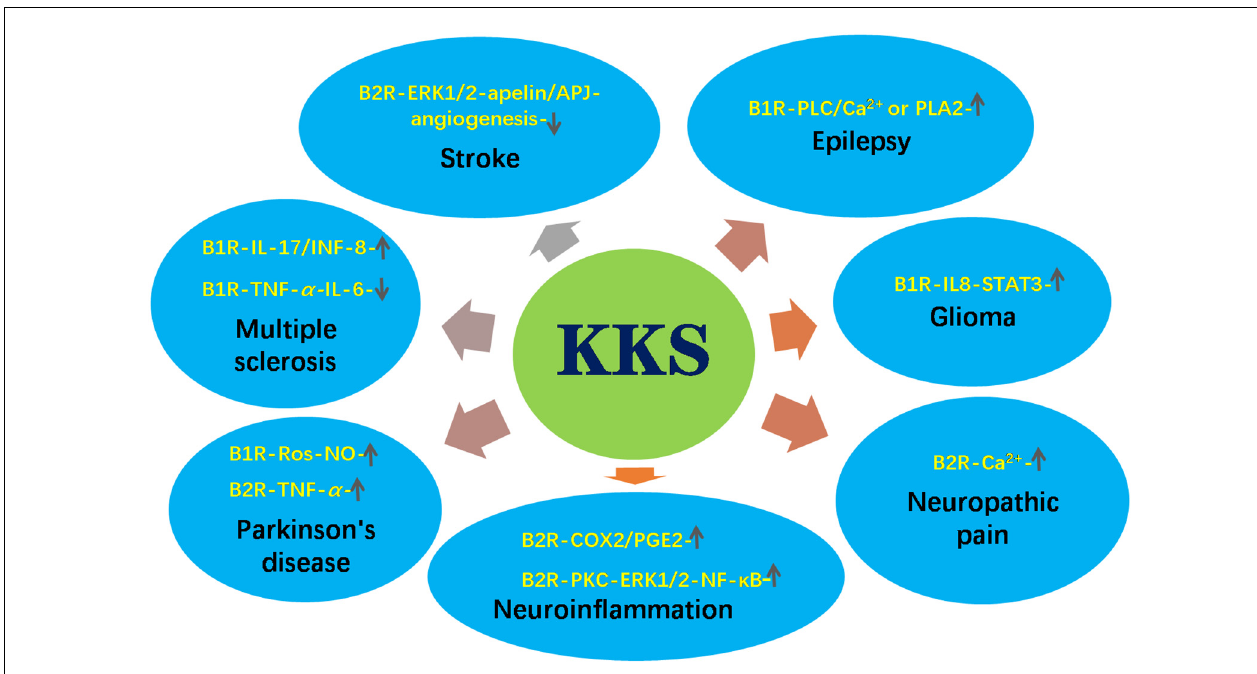
FIGURE 1 | The roles of kinin/kinin receptors system (KKS) in neurological diseases. The upward arrow indicates the pathways promoting the pathogenesis of the diseases. The downward arrow indicates the pathways inhibiting the pathogenesis of the